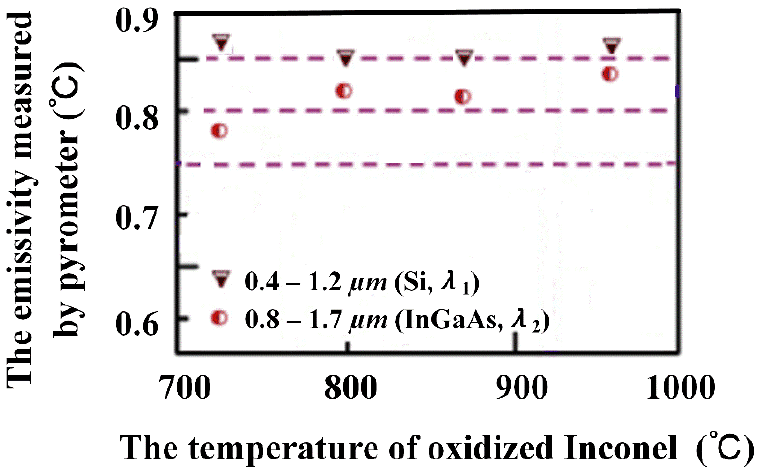
Figure 8. The variation in emissivity of oxidized Inconel at 700 – 1000 °C.